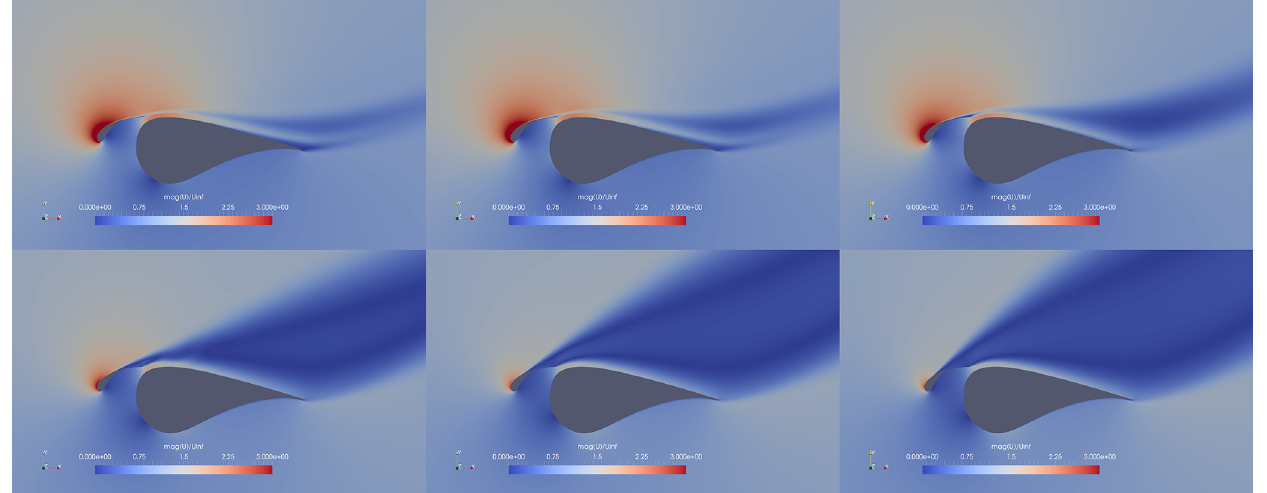
Figure B1. Flow fields around configuration C at the design Reynolds number and angles of attack ranging from α = 29 ◦ to α = 34 ◦ as predicted by CFD for the clean profile.